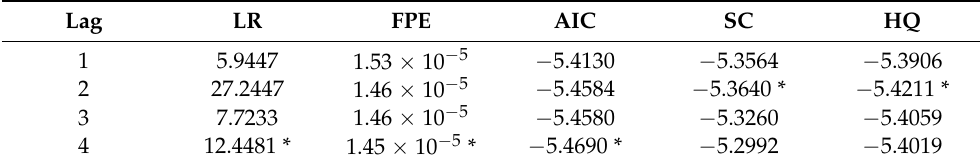
Table 2. The optimized VAR lag length selection process.